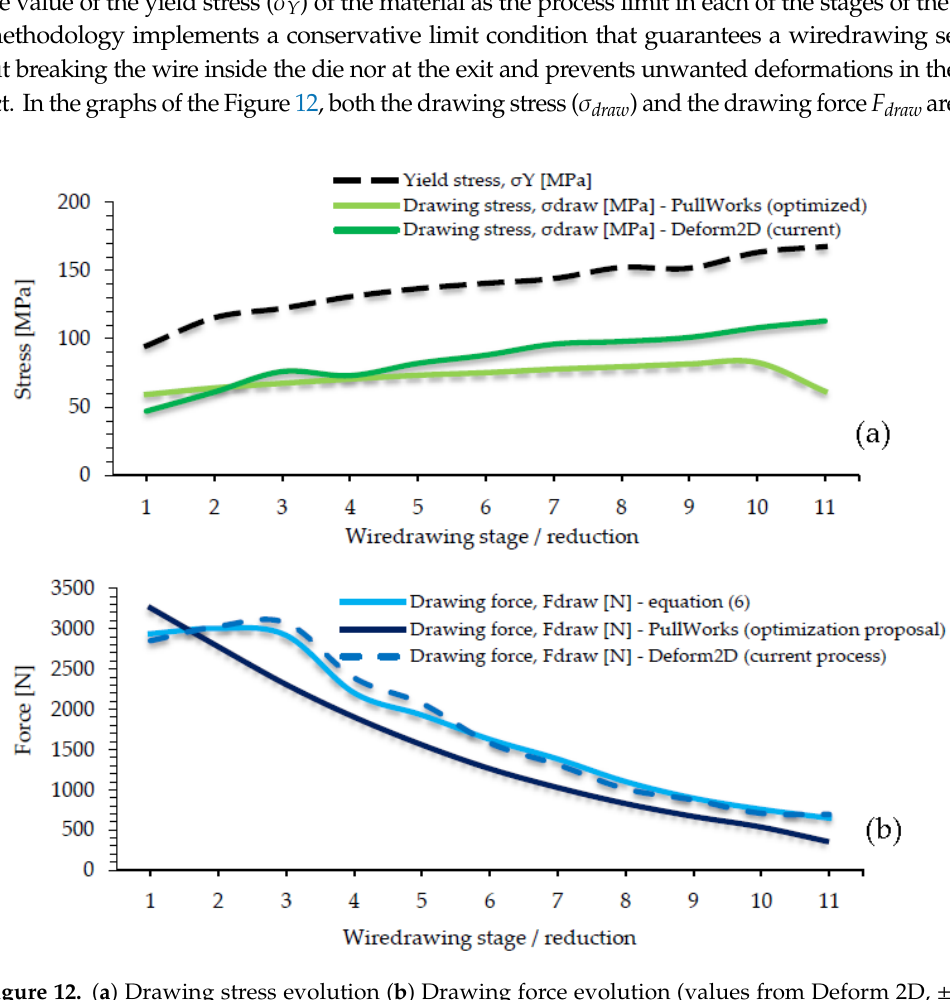
Figure 12. ( a ) Drawing stress evolution ( b ) Drawing force evolution (values from Deform 2D, ± 5% error